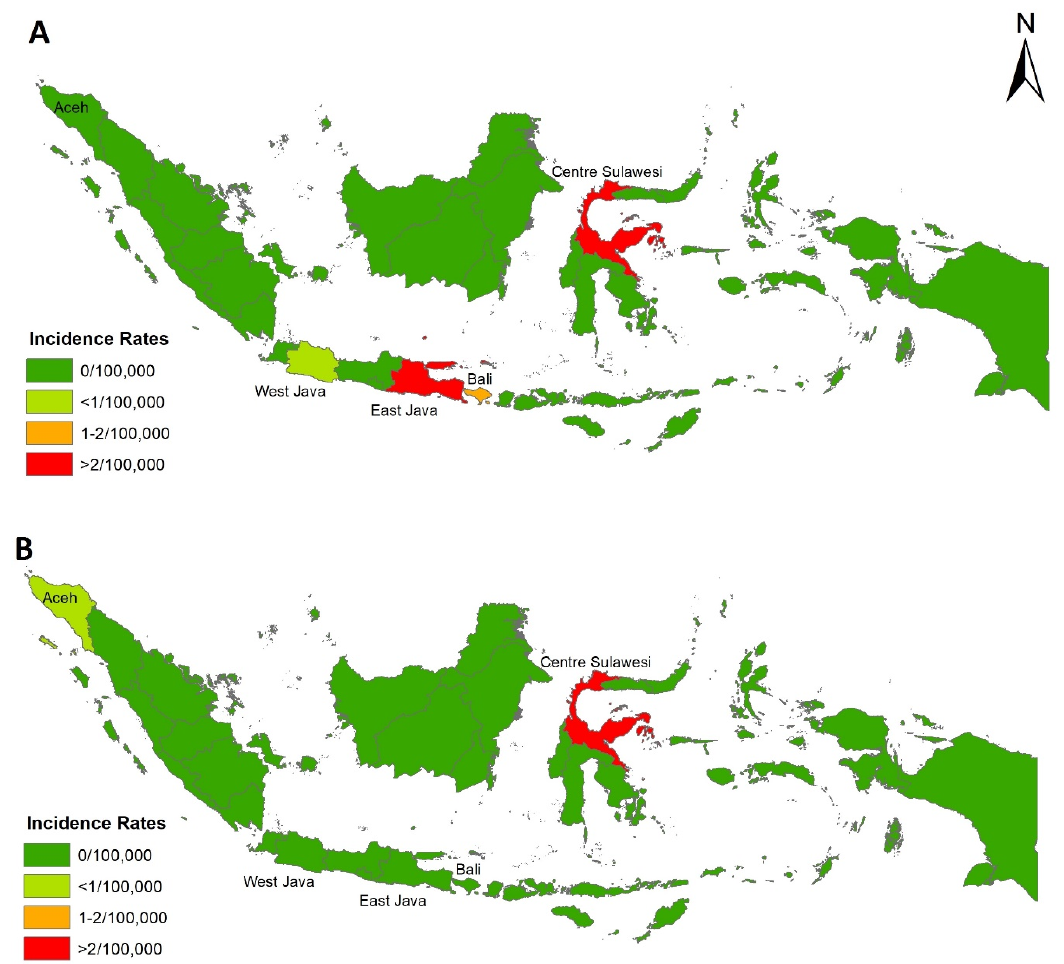
Figure 2. Provincial incidence rates of chikungunya in 2016 ( A ) and 2017 ( B ).